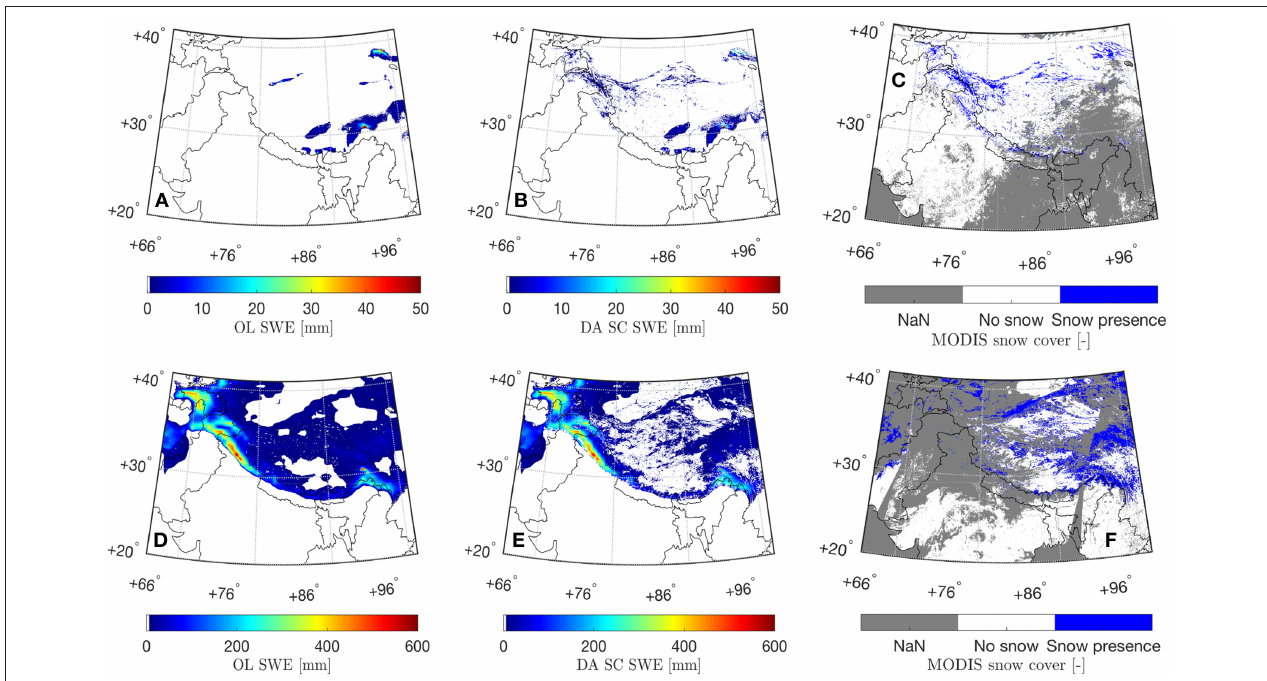
FIGURE 3 | Daily-averaged SWE estimates on 15 September 2007 derived from (A) OL and (B) SC DA. Daily-averaged SWE estimates on 3 February 2008 derived from (D) OL, and (E) SC DA. Assimilated MODIS snow cover maps are shown in (C) for 15 September 2007 and (F) for 3 February 2008, respectively, where “NaN" is the no-value indicator as discussed in section 2.2.